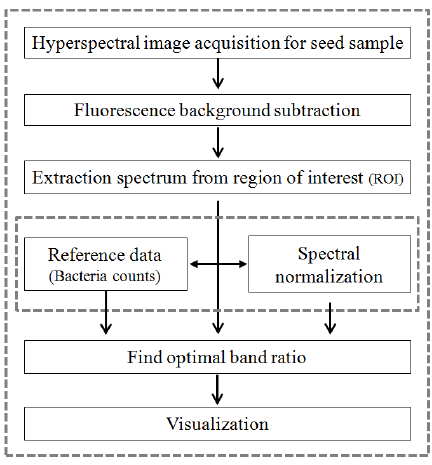
Figure 3. Flowchart of the development procedures for analyzing hyperspectral images and for displaying the difference between infected and healthy seed samples.